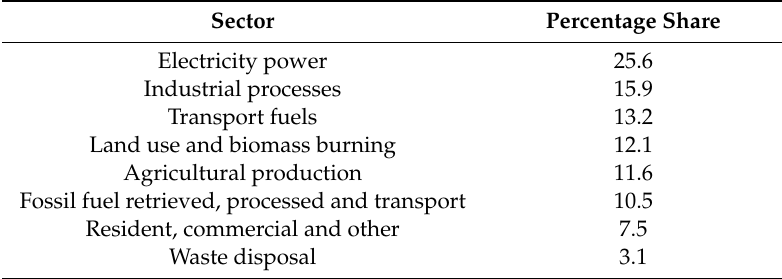
Table 1. Annual global greenhouse gas emissions by